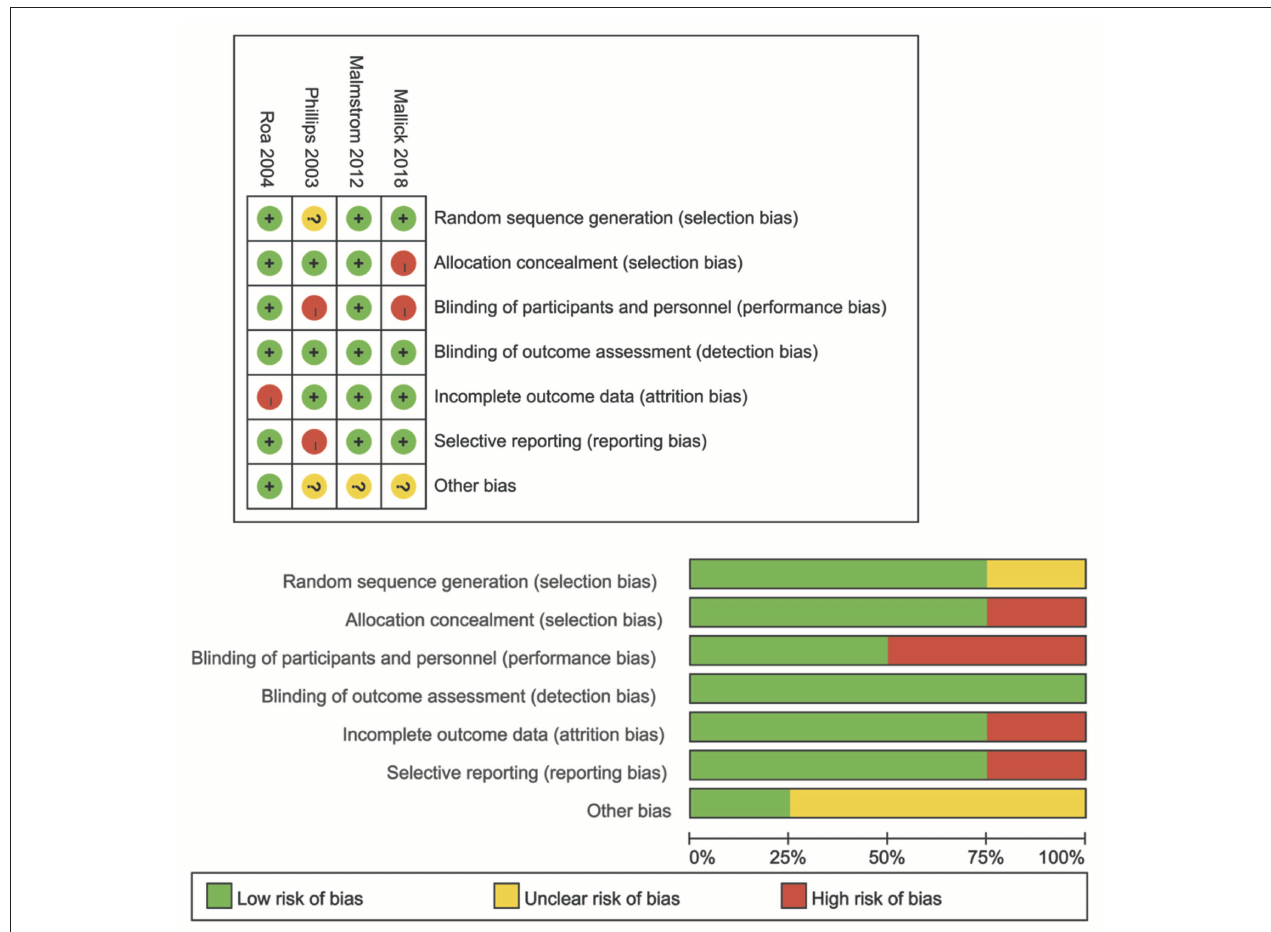
FIGURE 2 | Risk of bias